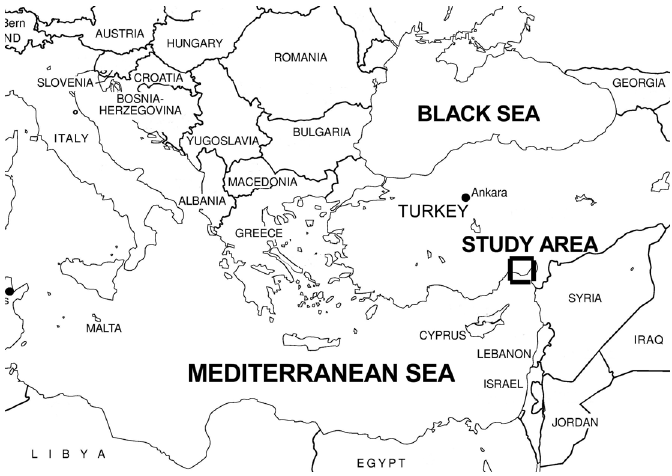
Figure 1. Location of the study